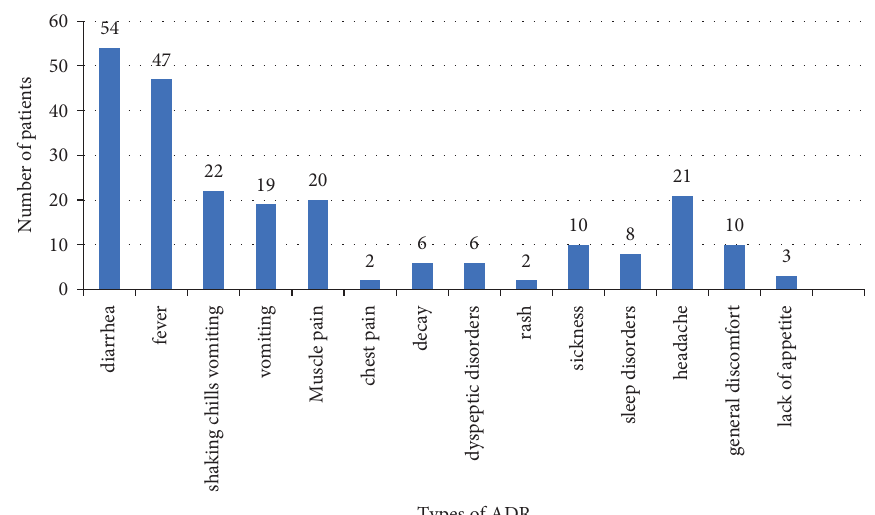
Figure 1: Type of ADRs observed in Cuban COVID-19 patients hospitalized in HEG-UCI, IPK, and Pinar del R´ıo. Source: completed surveys that were accessed in a digital database and printed surveys. ADR, adverse drug reaction. COVID-19, Coronavirus disease 2019.